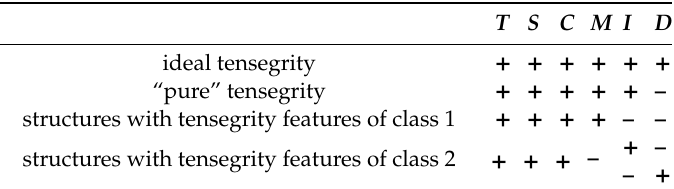
Table 1. Tensegrity classification, based on